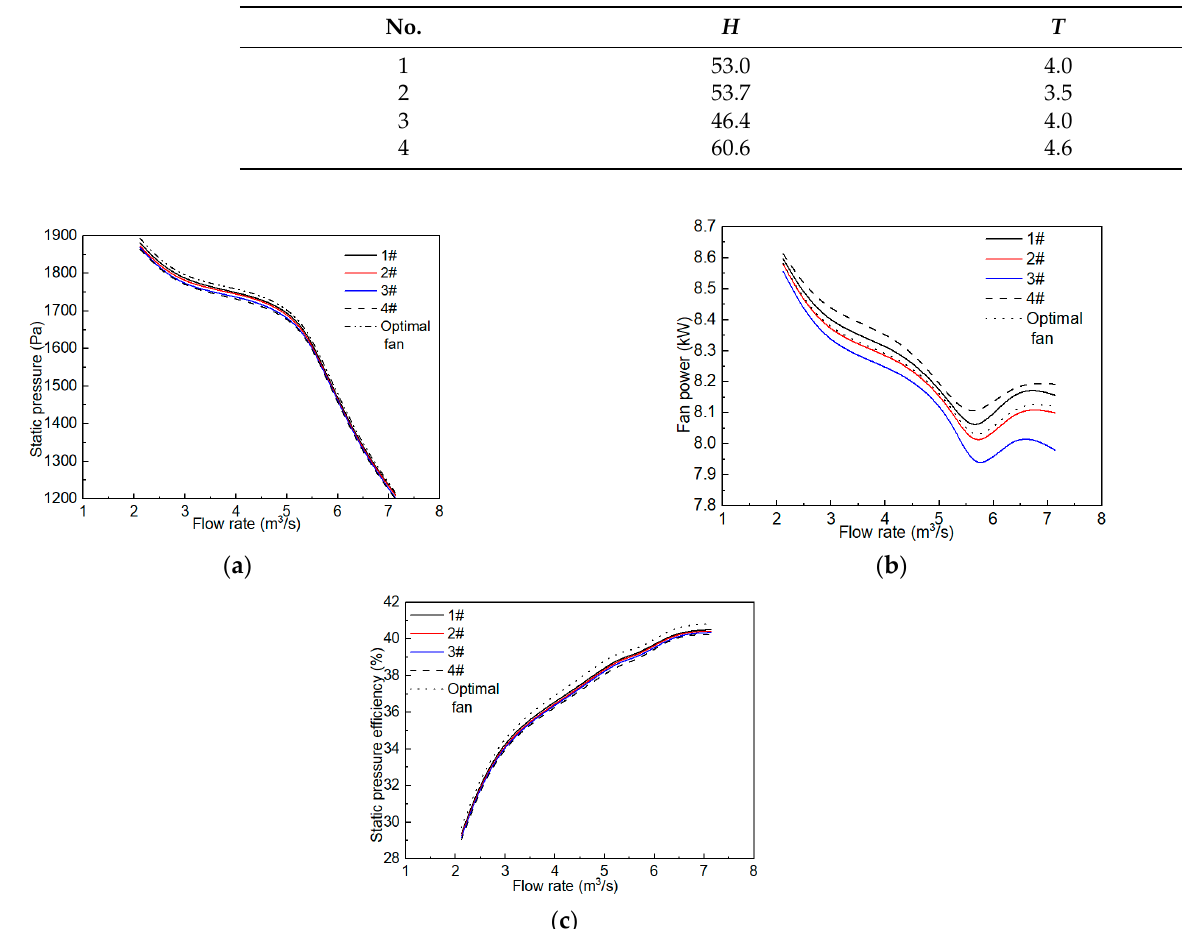
Table 5. Height and thickness values of four validation guiding fins (mm).